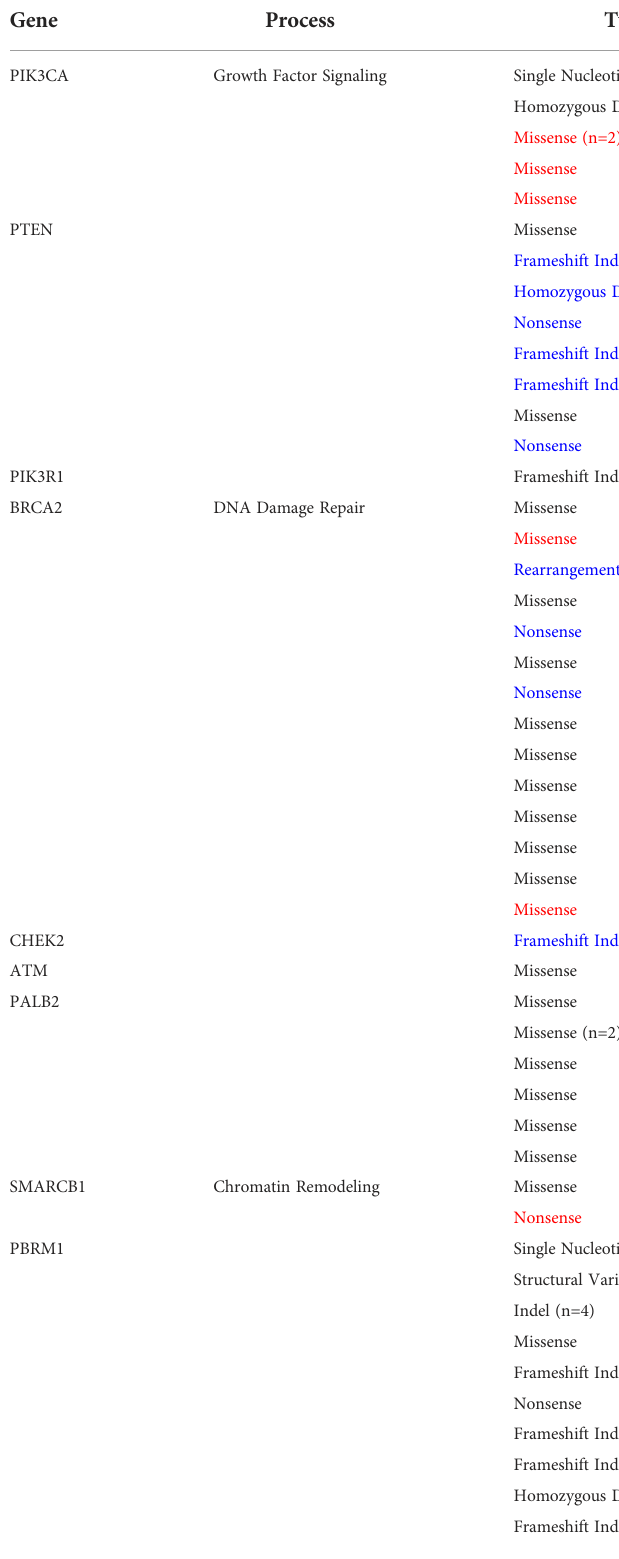
TABLE 1 Chordoma mutations reported in genes of potential therapeutic signi fi